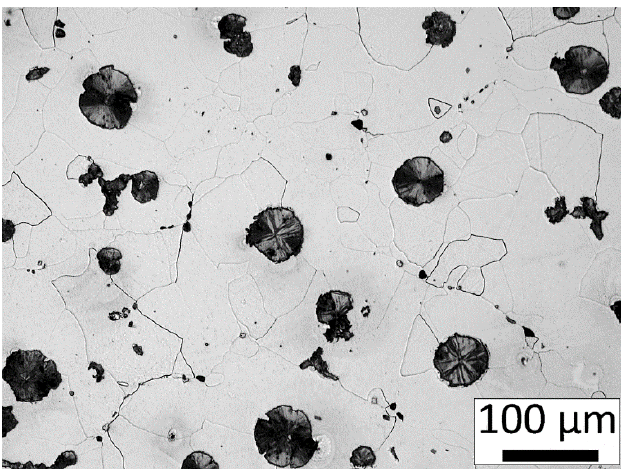
Figure 6. Optical micrograph of the SGI-1 specimen; thickness: 50 mm (Fully ferritic).